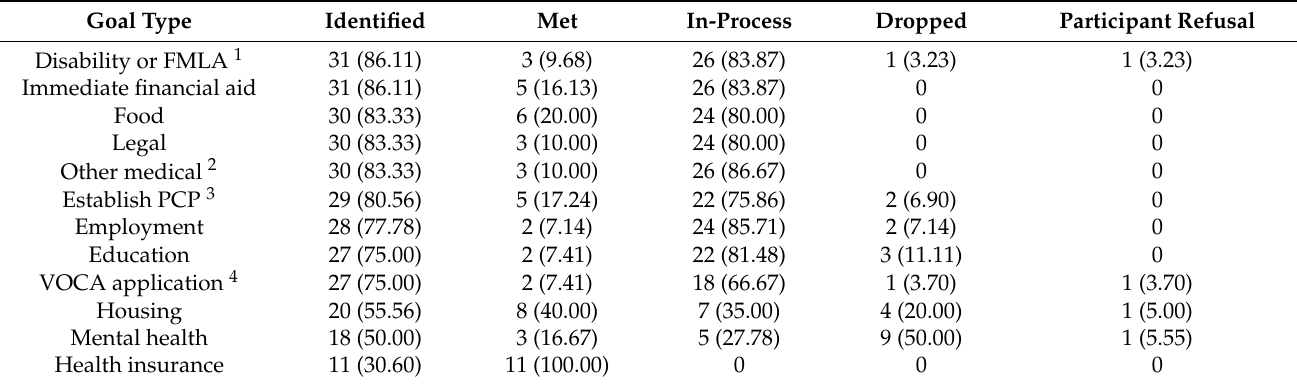
Table 1. Encompass Omaha Participant Goals and Status, n